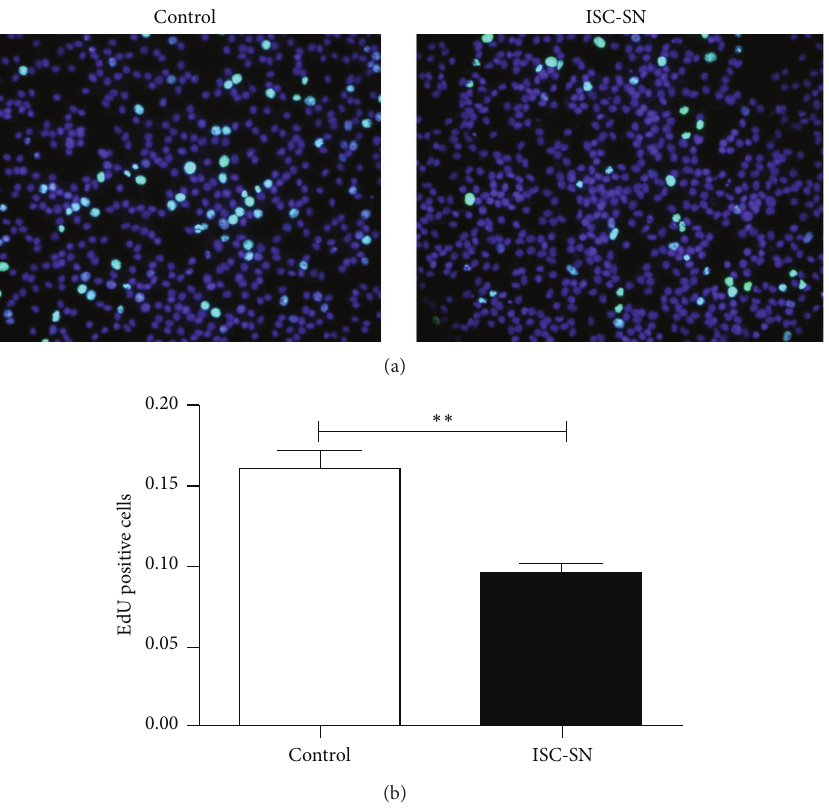
Figure 3: Effect of ISC-SN on INS-1 cell proliferation. (a) Cell proliferation was performed using EdU incorporation assay after treatment of INS-1 cells with ISC conditional medium for 48 h. Representative images for EdU staining (green) and nuclei labeled by DAPI (blue) at 200x magnification. (b) Data were expressed as mean ± SE ( 𝑛 = 3 ), ∗∗ 𝑃 < 0.01 .